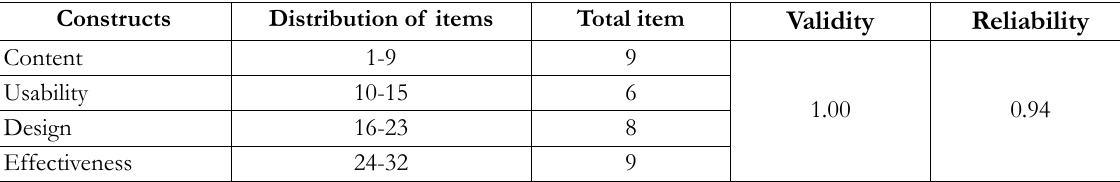
Table 5. Distribution of items in perception questionnaire (Hamid,